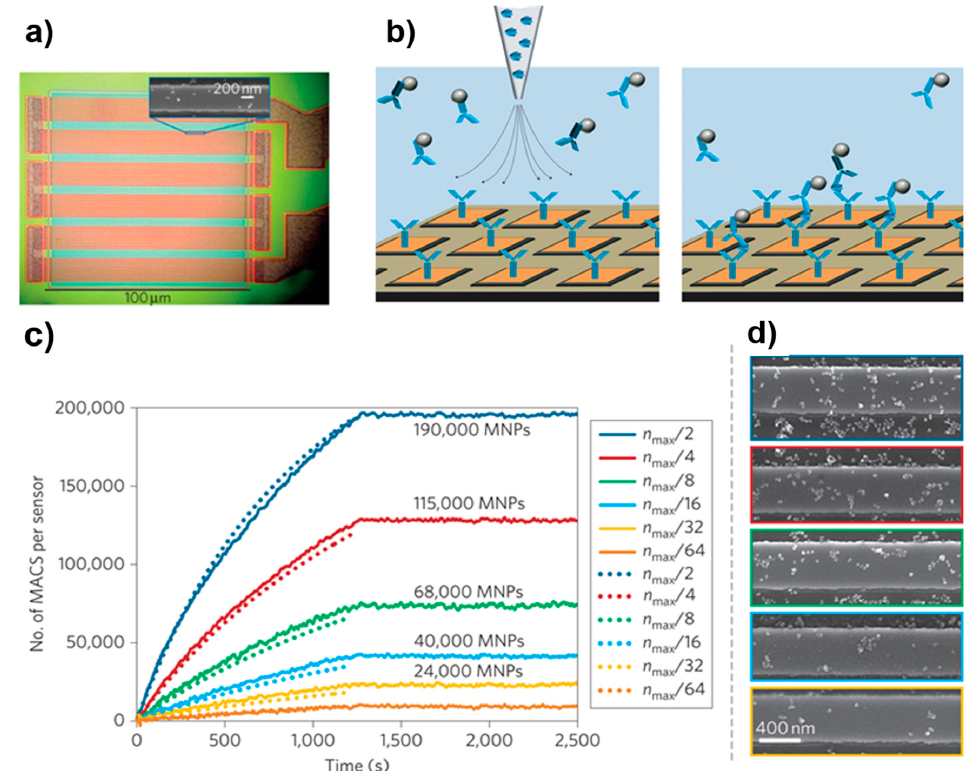
Figure 5. GMR applications: ( a ) optical image of GMR sensor architecture, where the upper right inset shows the SEM image of one strip with several bound MPs, ( b ) illustration showing the magnetic particle detection process, ( c ) real-time binding curve with fitting, and ( d ) SEM image of a section of the GMR sensor. Reproduced with permission from [12], copyright 2011 Nature Publishing Group.